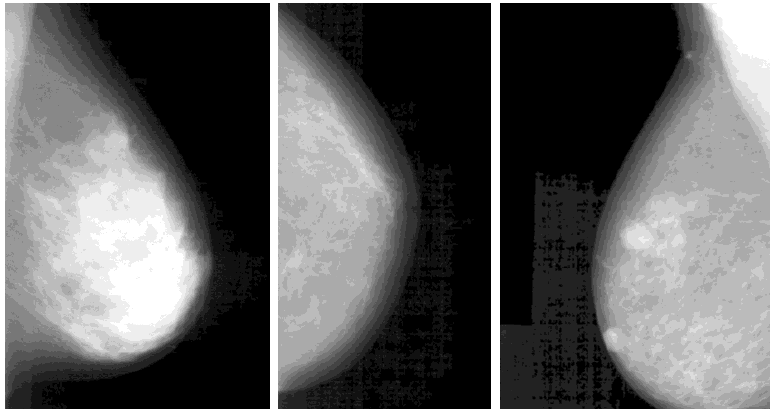
Figure 3. The three noisy images. Due to the periodic texture of the noise, it is likely that a gray-level co-occurrence or entropy-based approach could effectively filter